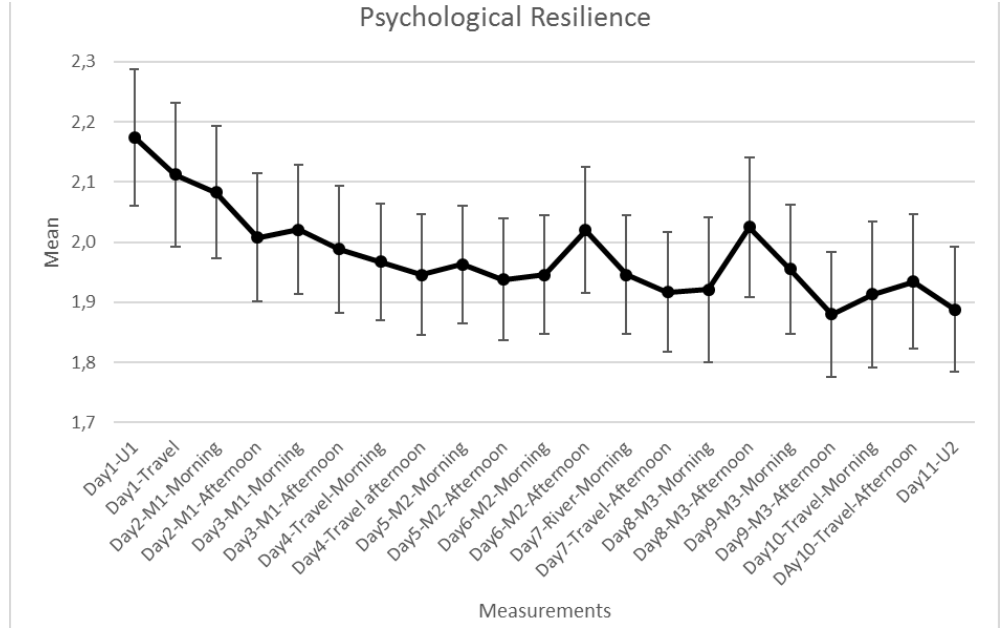
Figure 6. Psychological resilience of participants during the field trip ( N = 22; Answer scale 1 = totally agree to 7 = totally disagree).